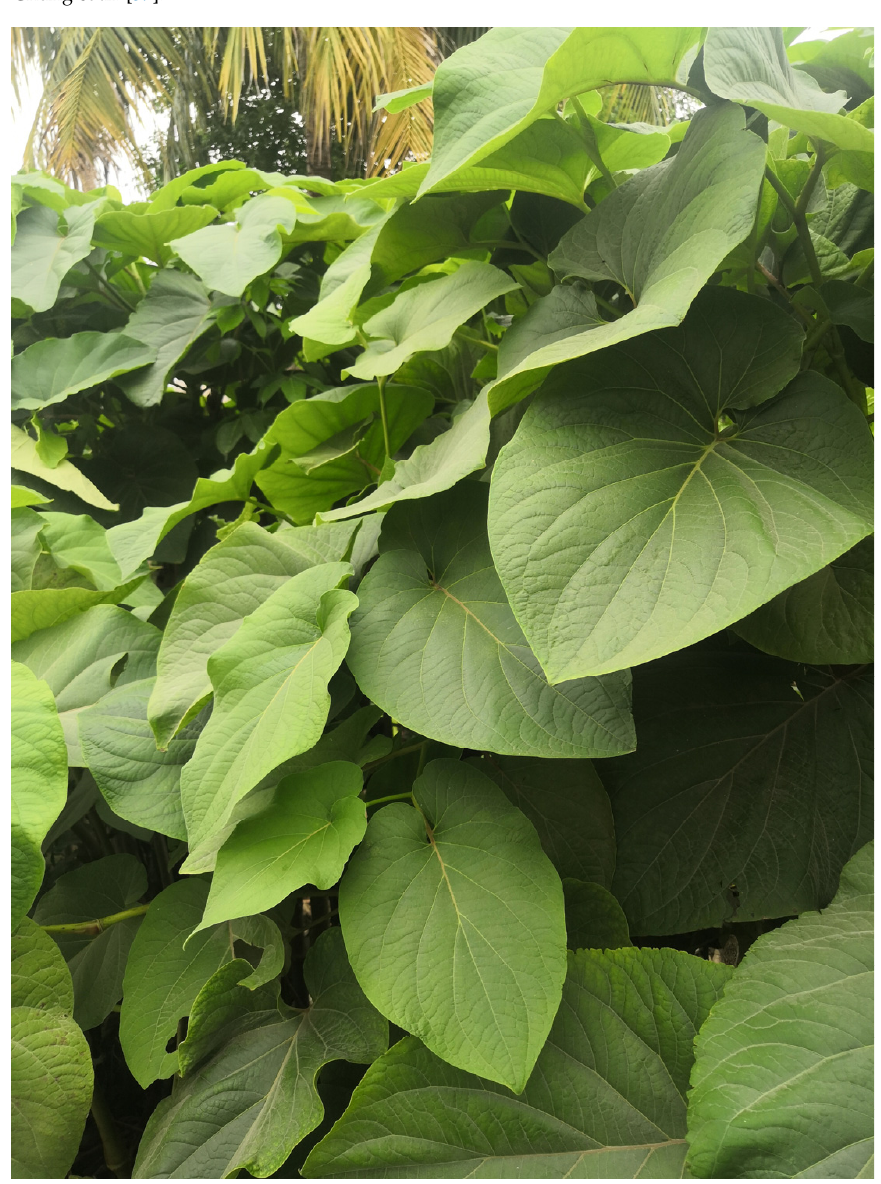
Figure 1. Fresh leaves of endemic Piper cordoncillo from the wild in Campeche, Mexico.